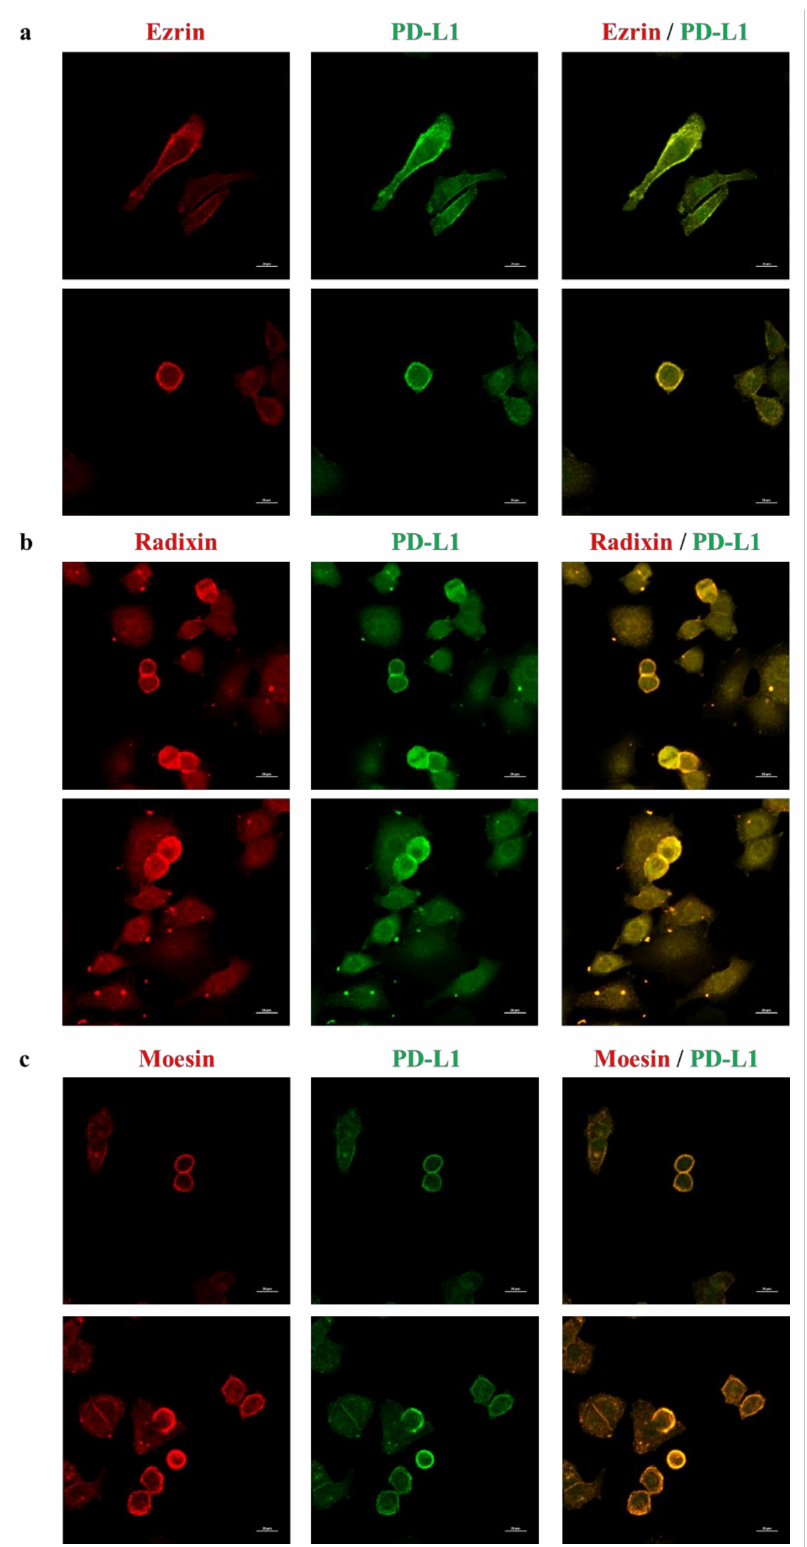
Figure 3. Colocalization of PD-L1 with ezrin, radixin, and moesin in the plasma membrane of HeLa cells. Confocal laser scanning microscopy for subcellular localization of ezrin, radixin, moesin, and PD-L1 in HeLa cells. In a three-dimensional reconstruction of optically sectioned HeLa cells, PD-L1 (green) was highly colocalized with ( a ) ezrin, ( b ) radixin, and ( c ) moesin (red) on the plasma membrane. Scale bars: 20 µ m. All data are representative of at least three independent